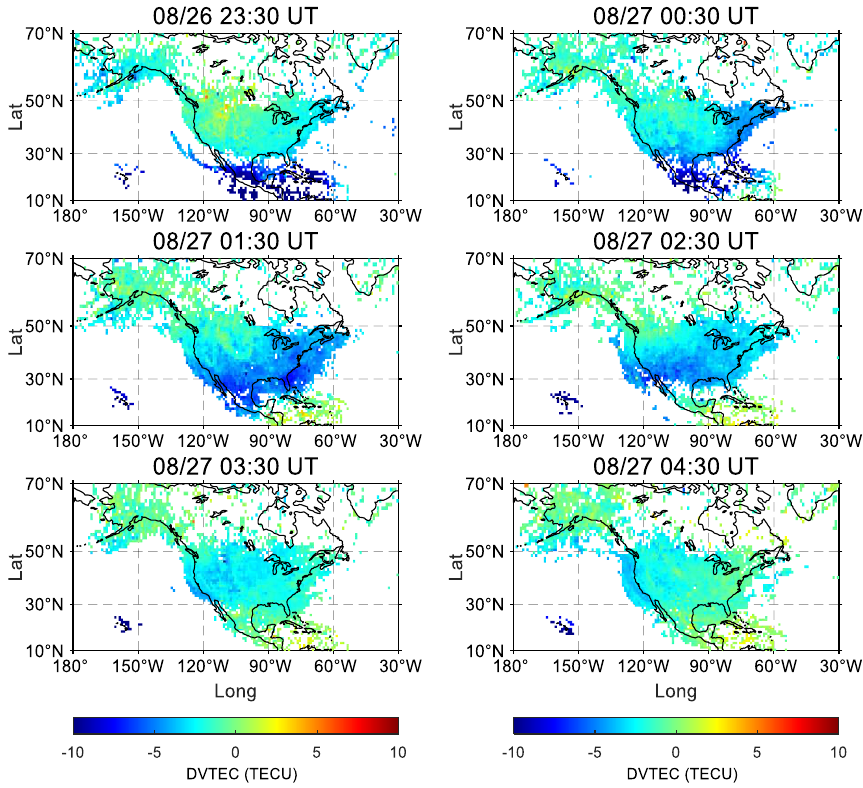
Figure 7. Spatiotemporal evolutions of storm-3.